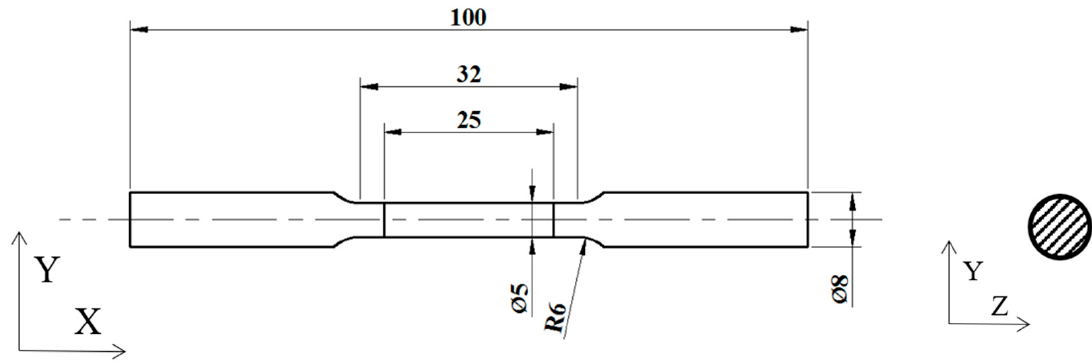
Figure 1. The Schematic diagram of tensile specimen.